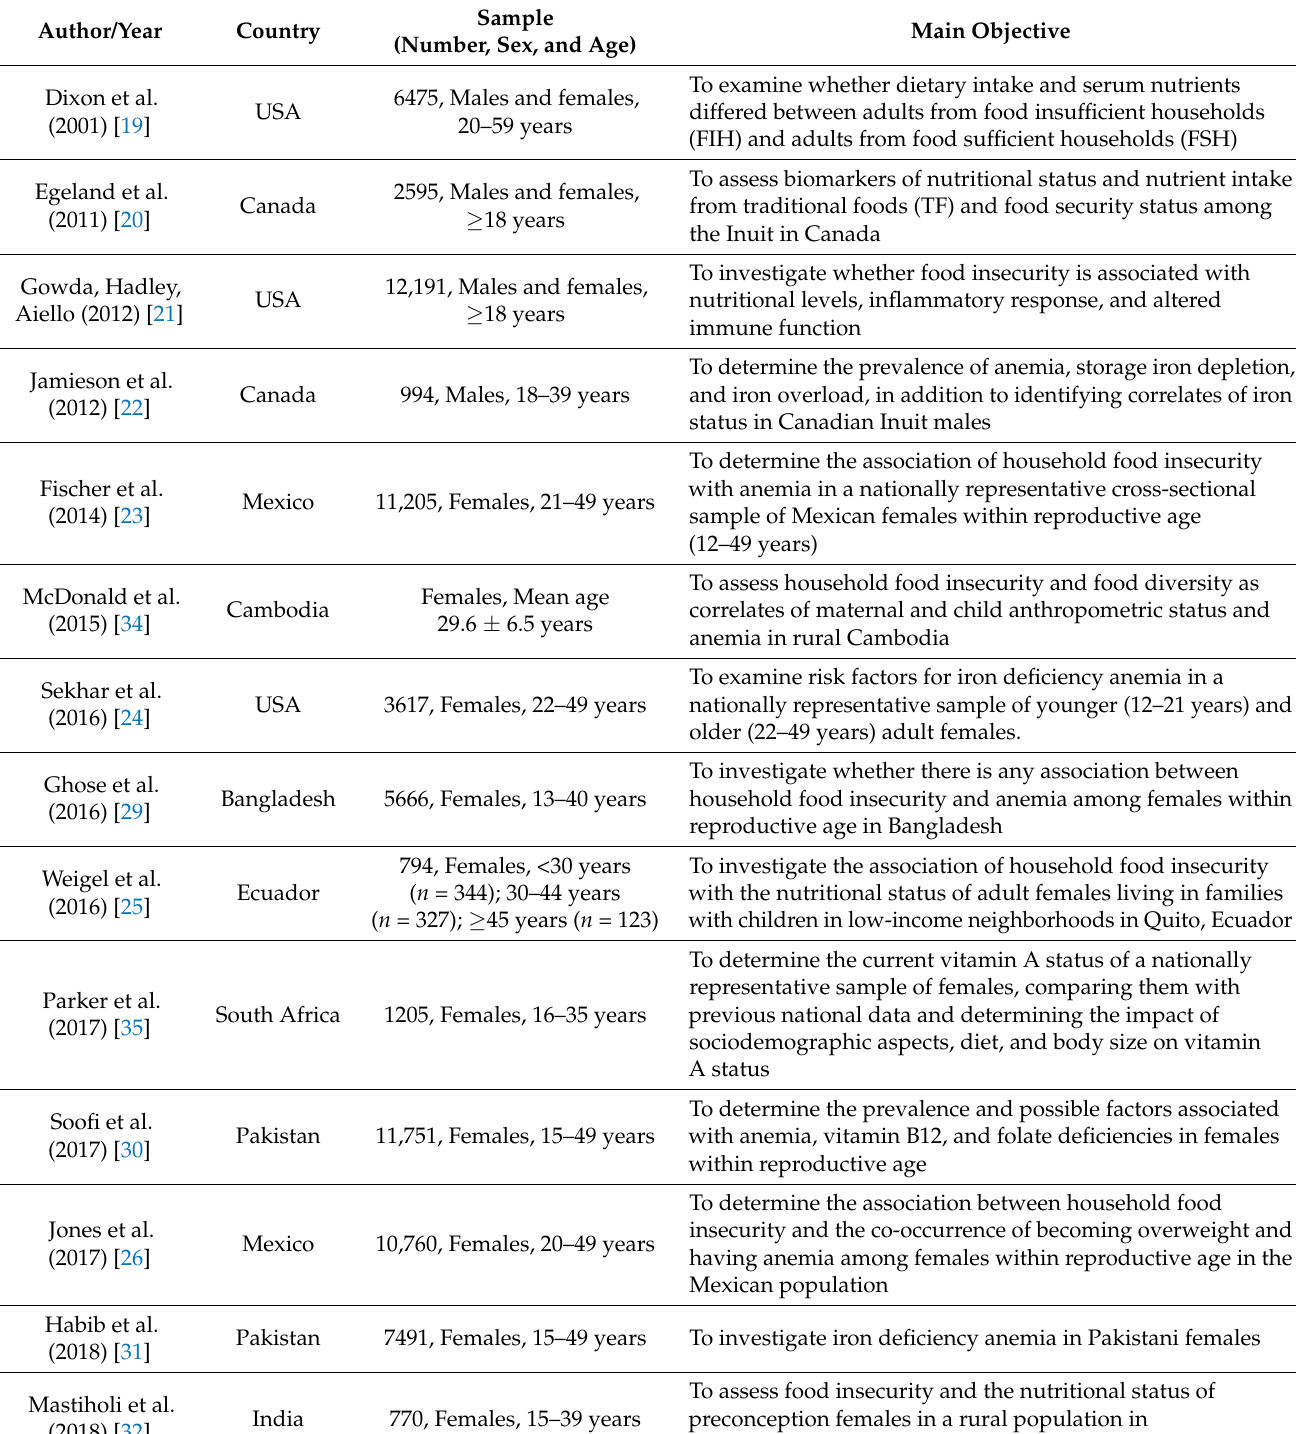
Table 1. Description of the included studies: author, year, country, sample, and